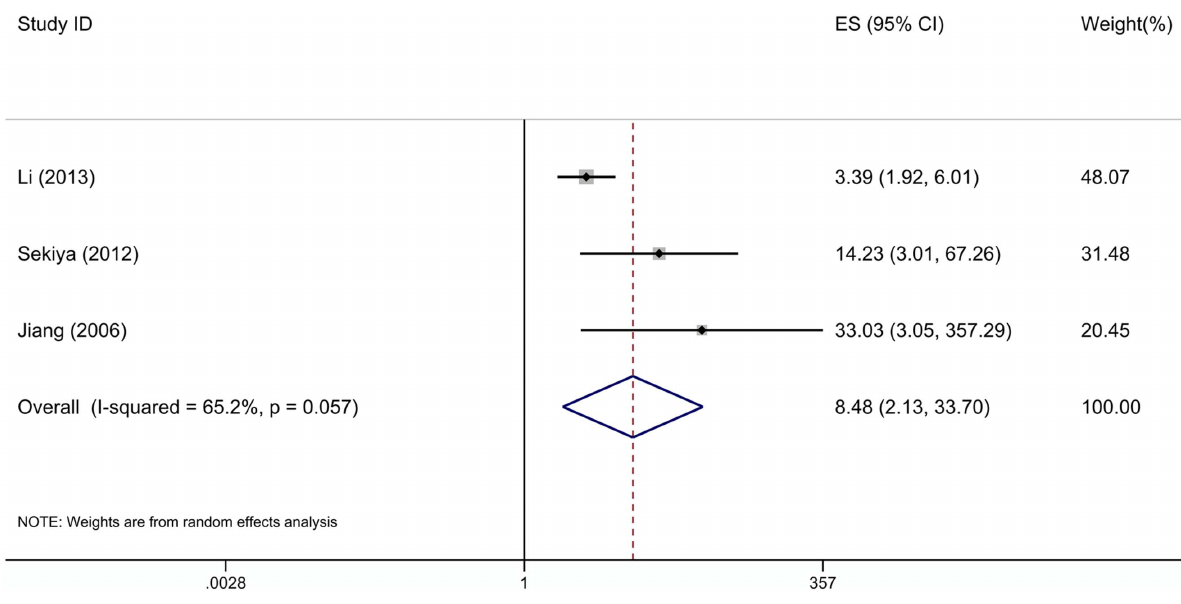
Figure 3. Forest plot showing the association between CXCR4 expression and PFS of ovarian cancer. doi:10.1371/journal.pone.0092629.g003 PLOS ONE |